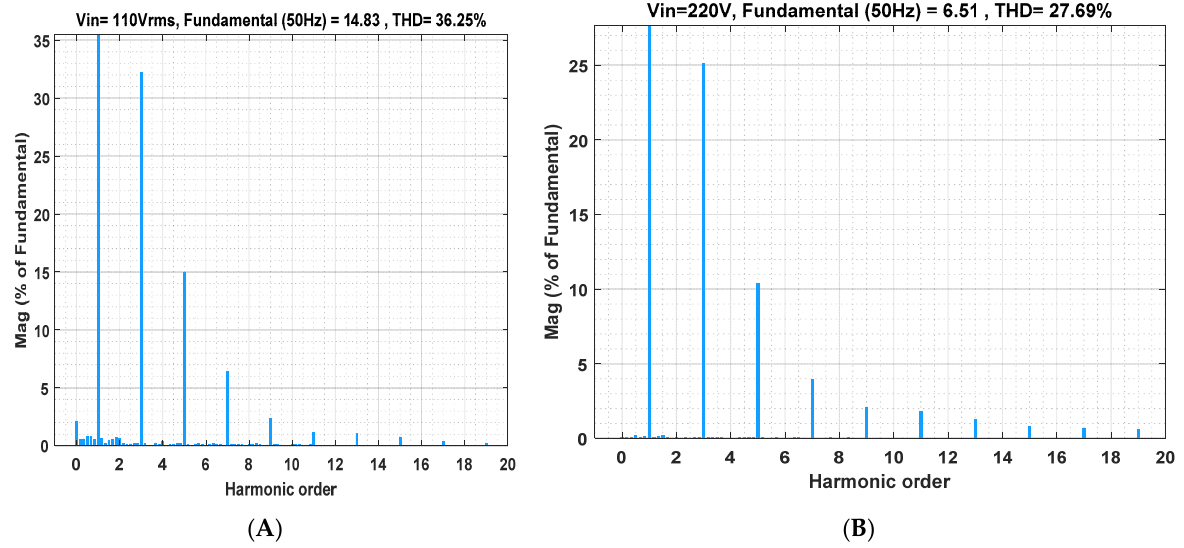
Figure 15. THDs when the input voltage is ( A ). 110 V rms , ( B ). 220 V rms.